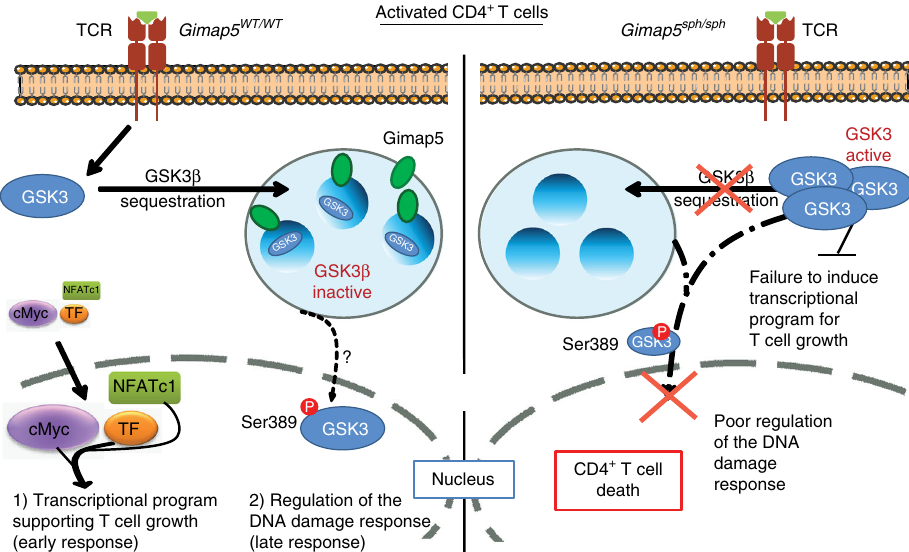
Fig. 9 Gimap5 is a critical regulator of GSK3 β during T cell activation. Gimap5 controls regulation of GSK3 β in T cells through vesicular sequestration and affects both the (1) (early) transcriptional program required for T cell growth, and (2) the late stage nuclear accumulation of P-Ser389 GSK3 β required for the DNA damage response during cycling. Gimap5-de fi cient CD4 + T cells, fail to inhibit GSK3 β leading to a failed transcriptional program and increased DNA damage during T cells